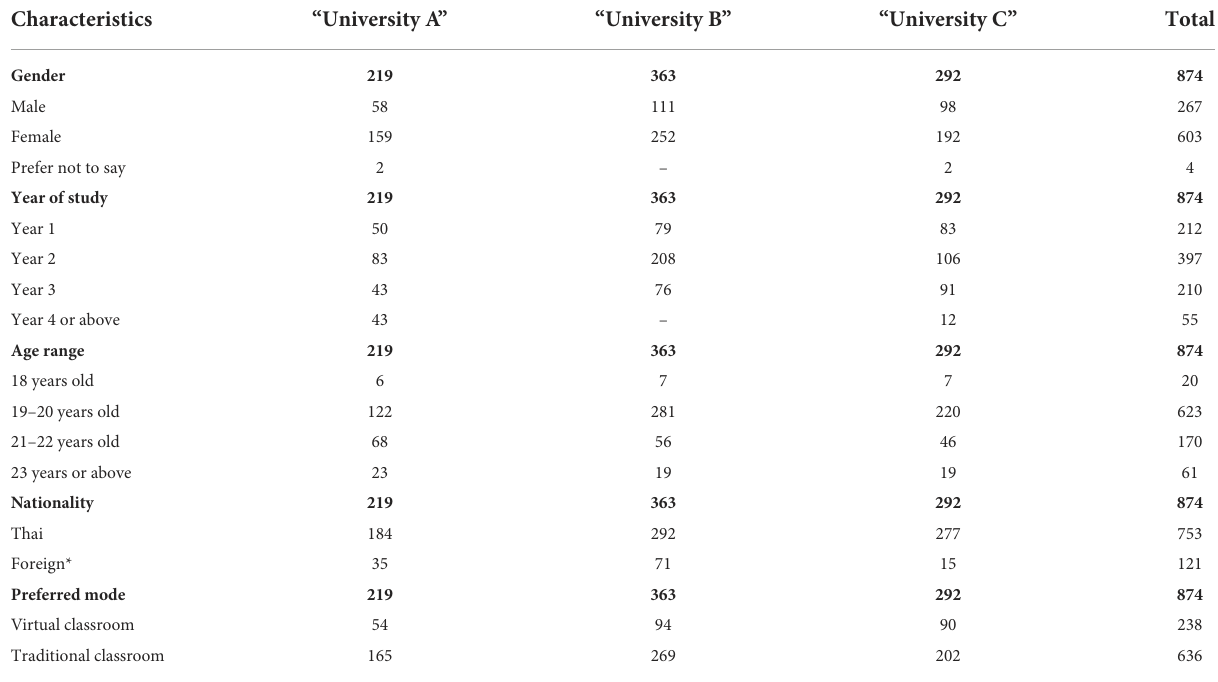
TABLE 4 Characteristics of the participants organized by their institution.